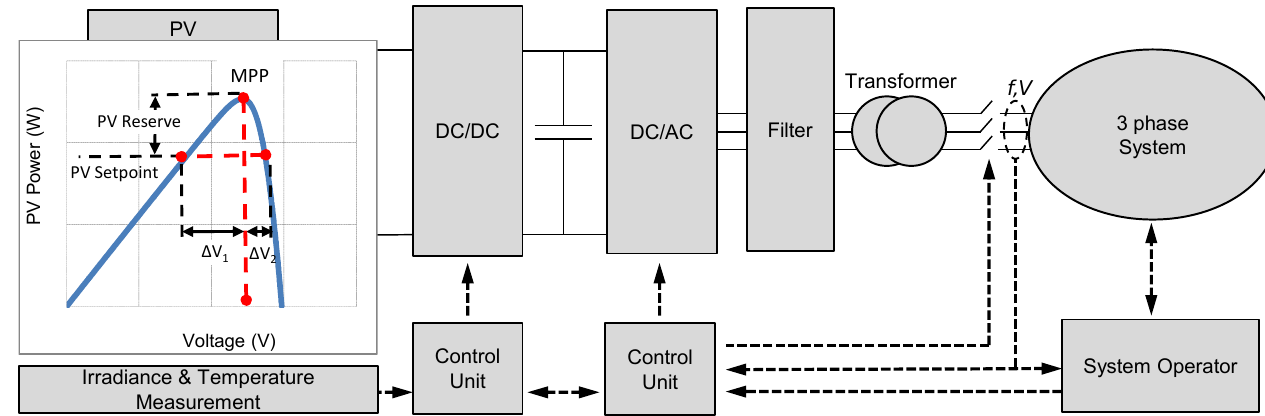
Figure 7. A principal scheme of PV facility with frequency ‐ power control.